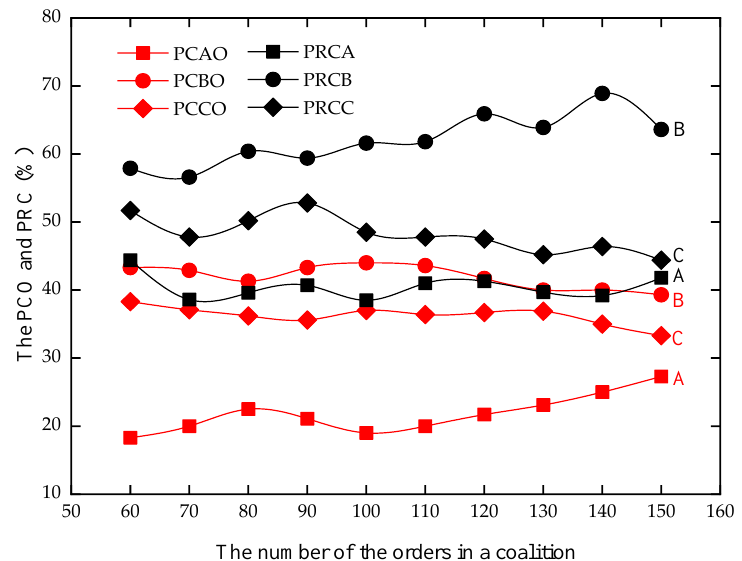
Figure 8. The relationship between PCO and PRC .